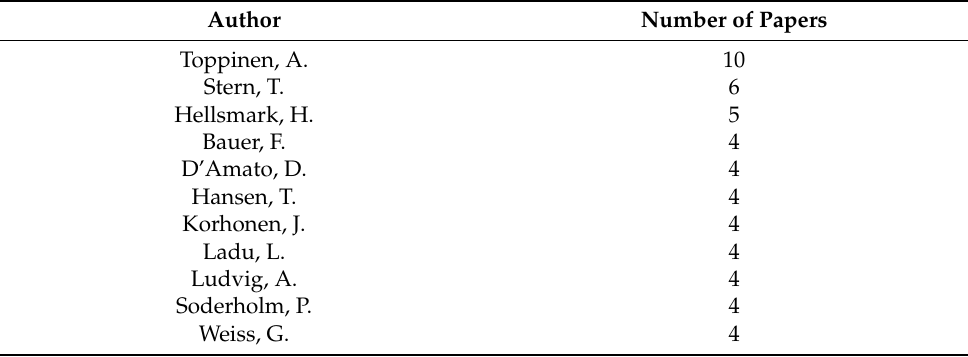
Table 2. Eleven authors with more than three publications in the dataset.